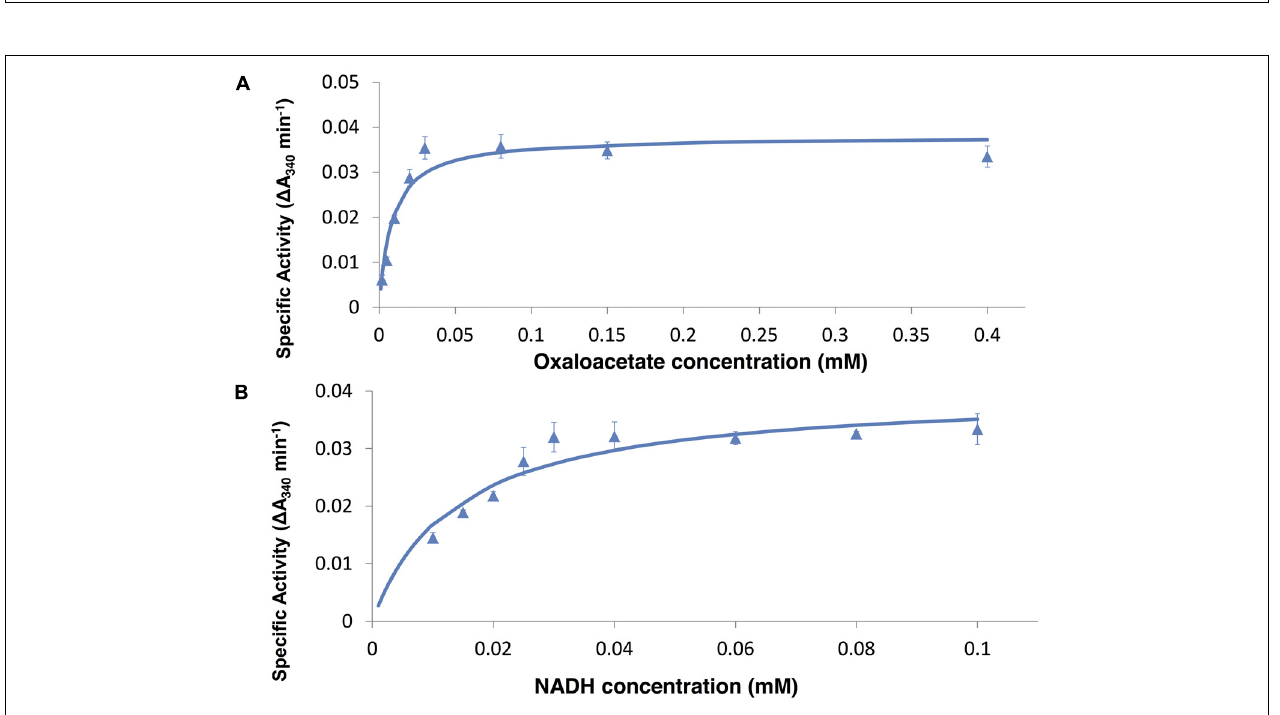
FIGURE 3 | Enzyme assay of Sy MDH in the reductive reaction in vitro . (A) Activity was measured by varying the oxaloacetate concentration at a fixed NADH concentration (0.1 mM). The graphs show the mean ± SD obtained from three independent experiments. (B) Activity was measured by varying the NADH concentration at a fixed oxaloacetate concentration (0.1 mM). The graphs show the mean ± SD obtained from three independent experiments.